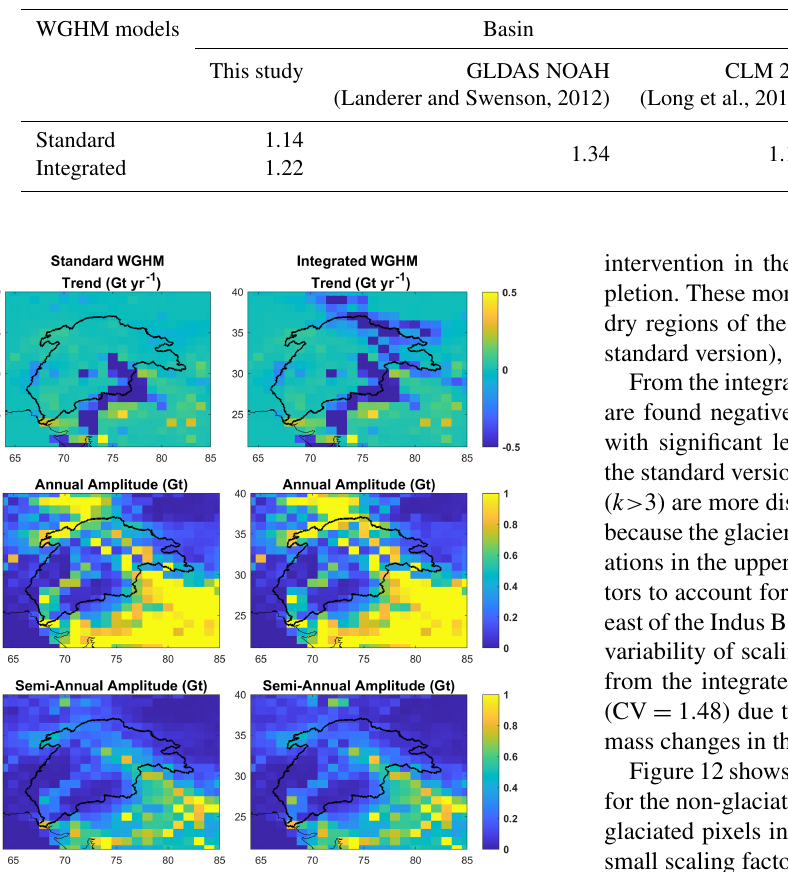
Figure 7. Spatial patterns of trend, annual, and semi-annual mass changes from WGHM standard (left) and integrated (right) ver- sions. Table 4. Interpretation of gridded scaling